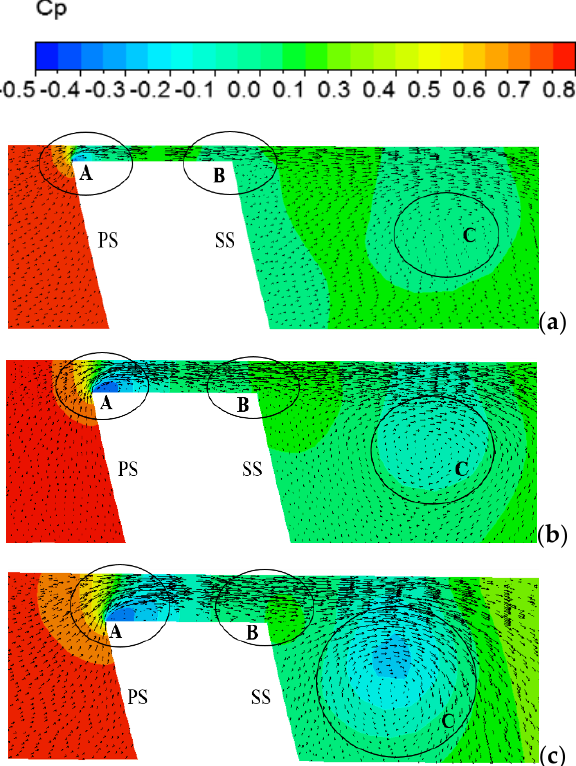
Figure 8. Pressure coefficient and velocity vector distribution at λ = 0.5 (designed Q). ( a ) δ = 0.25%; ( b ) δ = 0.5%; ( c ) δ = 0.75% .